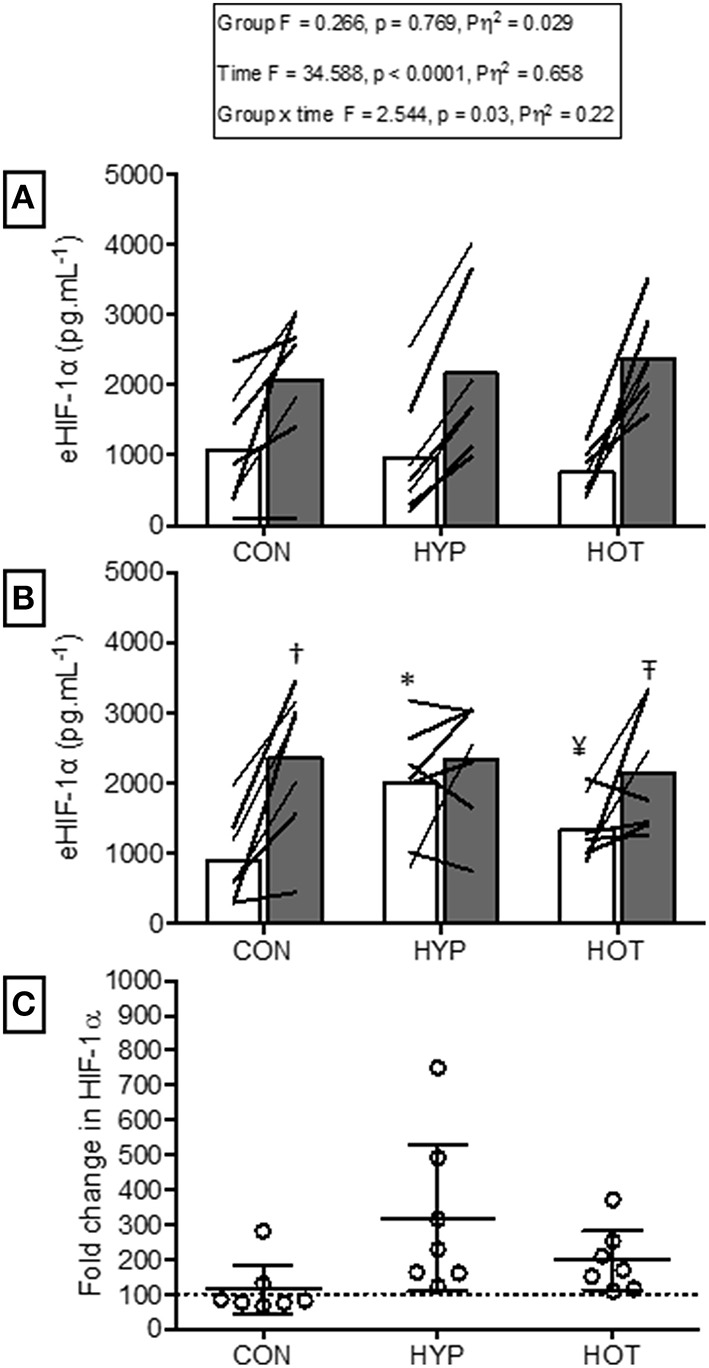
Extracellular HIF-1α responses before and after HST1 and HST2. (A) eHIF-1α increased in response to exercise in HST1 in all experimental groups. (B) Prior to HST2 resting levels of eHIF-1α were elevated in HYP when compared to pre HST1, and showed a varied individual response in HOT.eHIF-1α increased in response to exercise in HST2 in CON, but was unchanged in both HYP and HOT, although individual variation in the data is present. (C) The magnitude of change in resting eHIF-1α was not different between HYP and HOT prior to HST2, and each were elevated in comparison to CON. Lines (A,B) and dots (C) represent individual participant responses and bars the mean group response. The dashed line (C) represents baseline HIF-1α. Different from rest (p < 0.01) within trial. *Different from HST1 pre-exercise (p < 0.01). ¥Different from HST1 pre-exercise (p < 0.05). – TDifferent from HST2 pre-exercise (p < 0.10). †Different from control (p < 0.05).